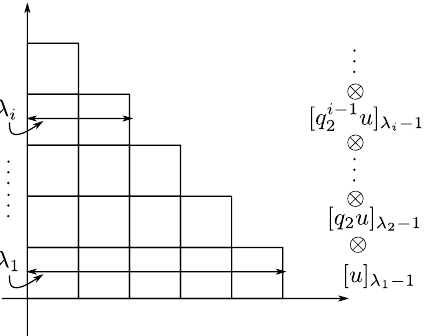
Figure 6. Young diagram and the basis of Fock representation. This is the generalization of figure 5 to the infinite number of